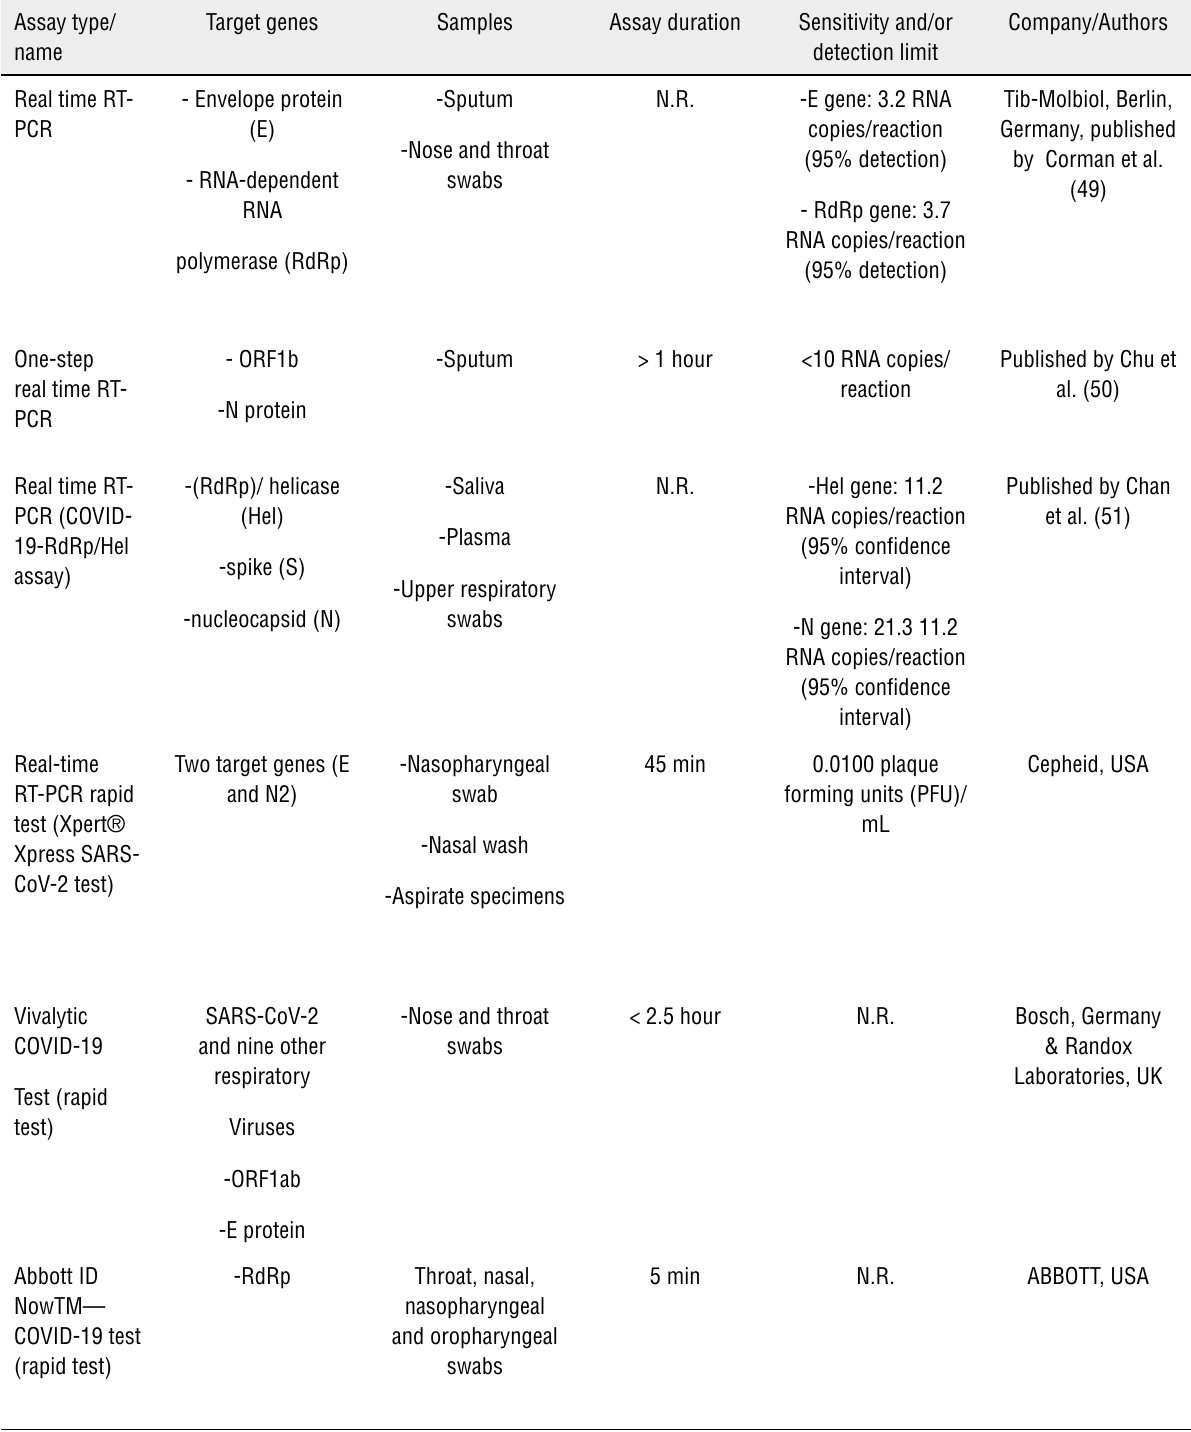
Table 2- Summary of in vitro diagnostic assays based on SARS-CoV-2 viral nucleic detection Assay